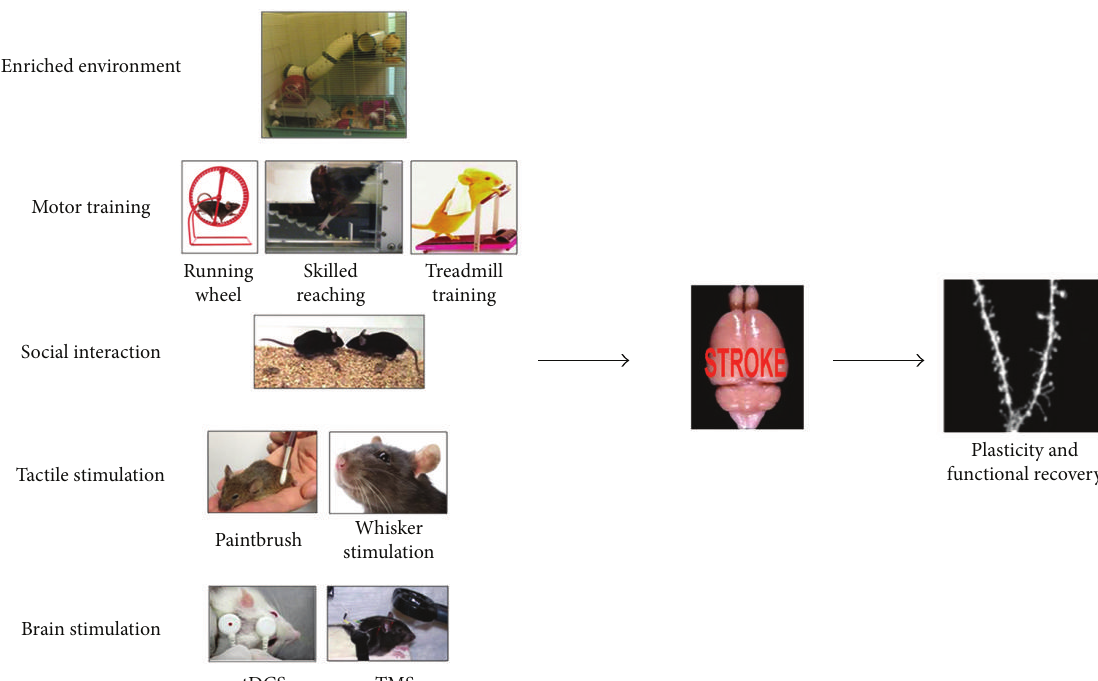
Figure 1: Figure 1 summarizes some of the most used noninvasive strategies to promote neural plasticity and functional recovery in experimental models of